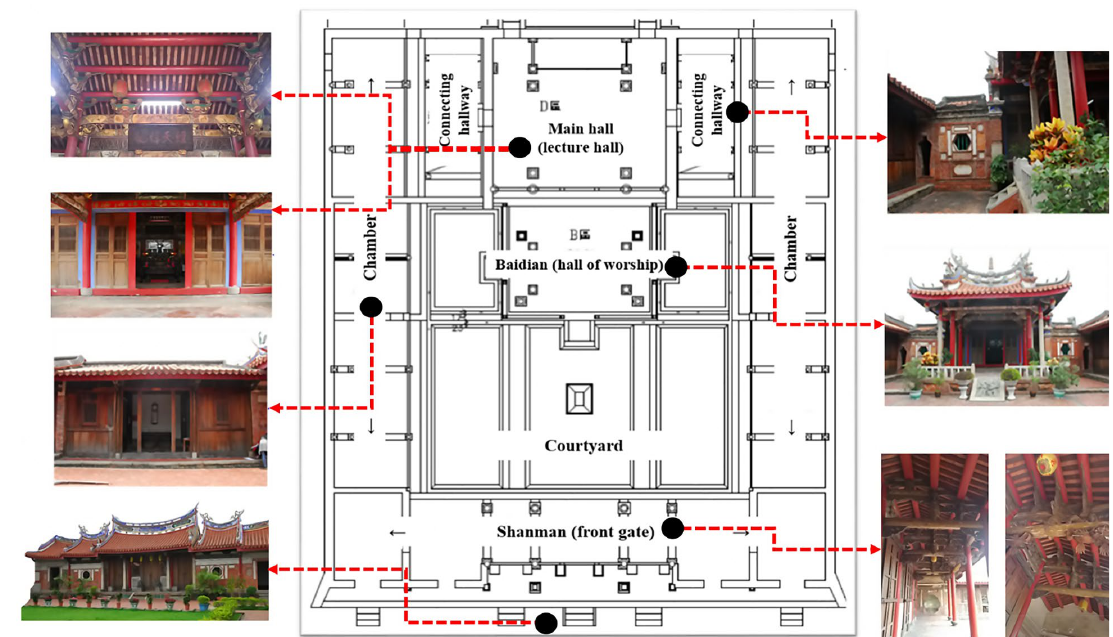
Figure 4. Spatial layout and current status of Huangxi